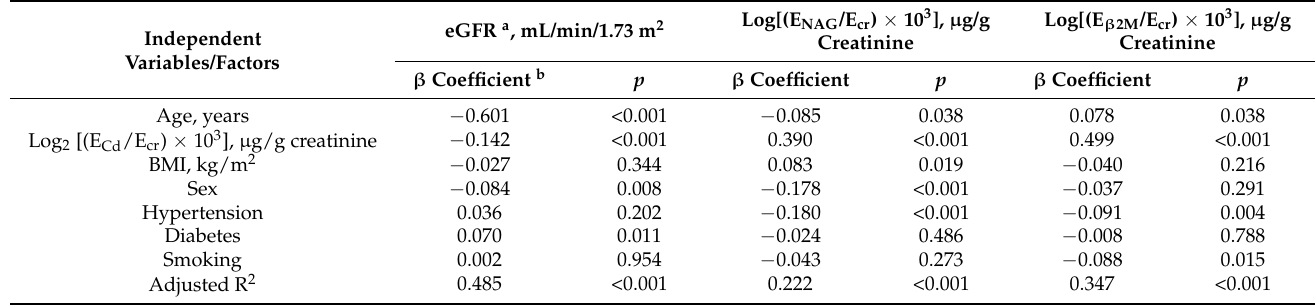
Table 3. Associations of the markers of kidney effects with E Cd /E cr .